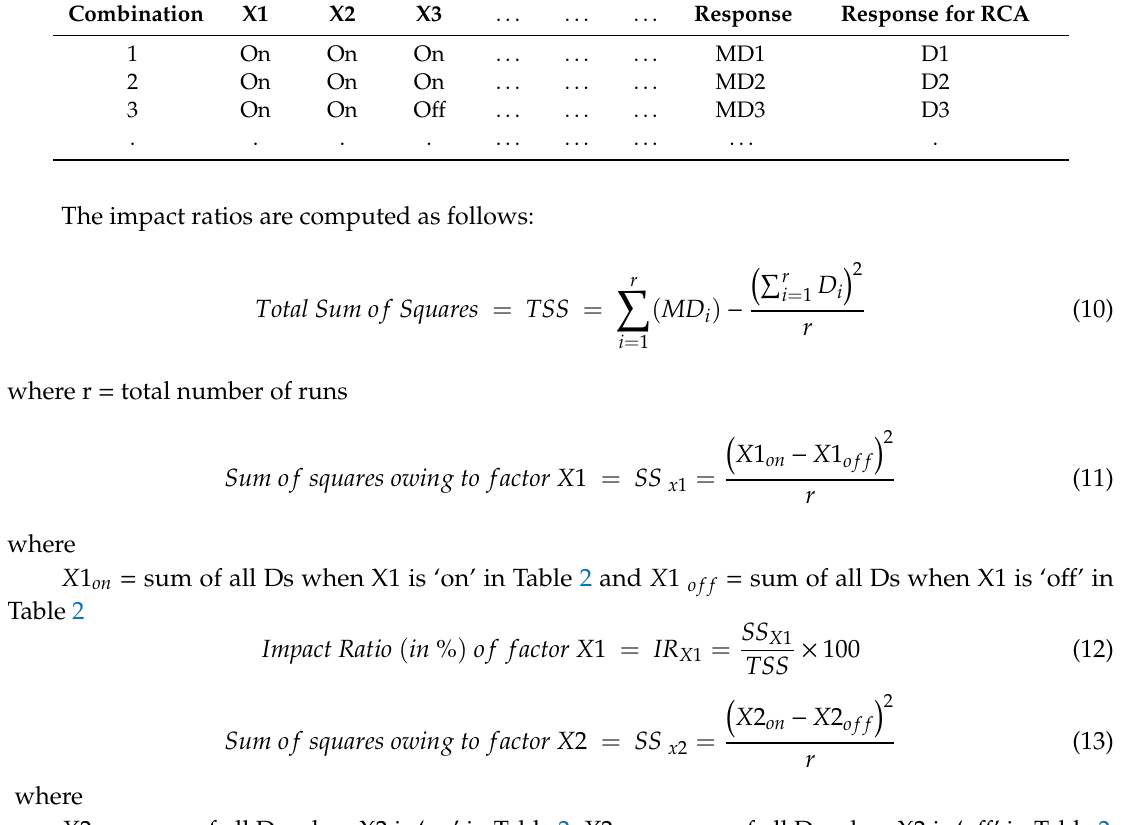
Table 2. Fractional factorial design or orthogonal array with 12 runs and 11 columns.